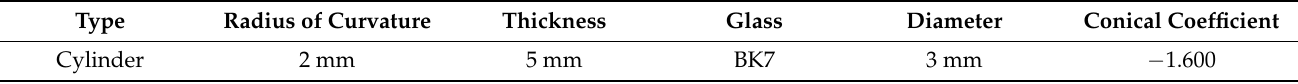
Table 1. The parameters of the Powell